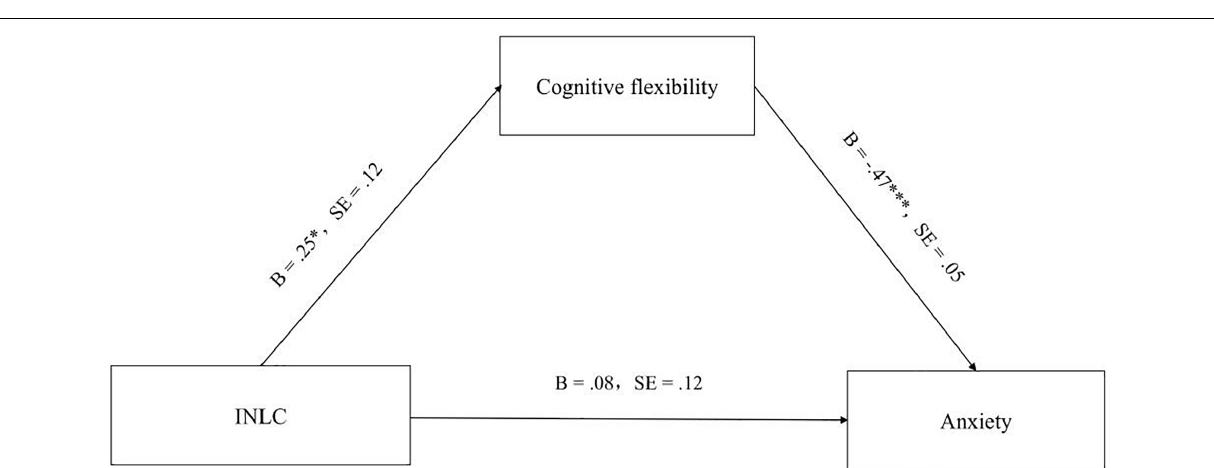
FIGURE 1 | The mediating of effect of cognitive flexibility on the link between CINL and depression in the entire sample.